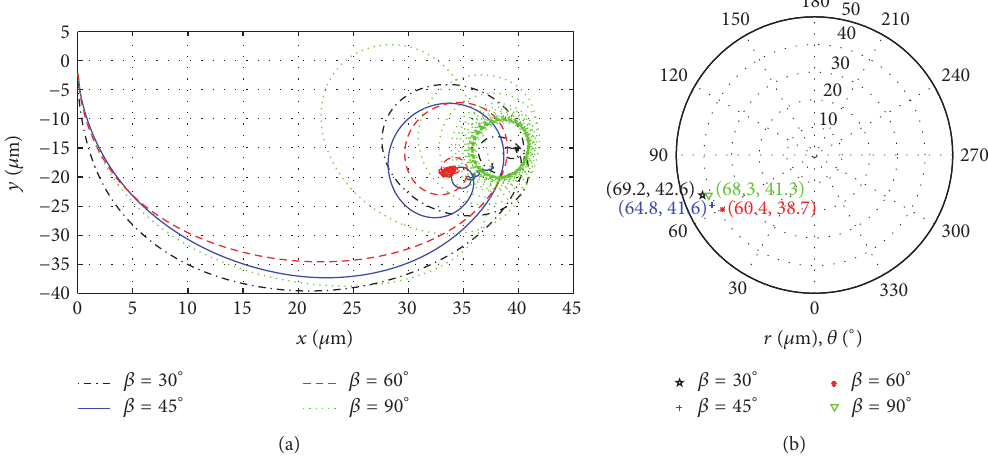
Figure 13: (a) Rotor trajectory and (b) polar coordinates of the HGGJB under different spiral angles at the rotating speed of 10000